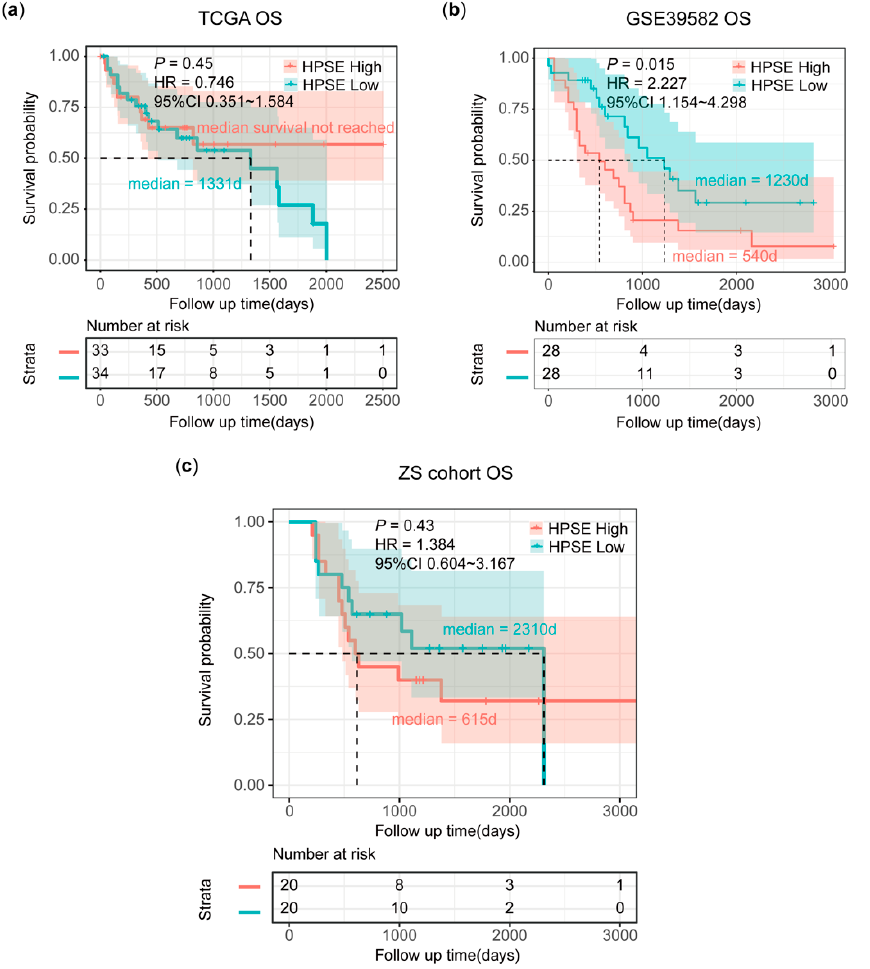
Figure 7. Kaplan–Meier survival curves for pMMR mCRC in TCGA ( a ), GSE39582 ( b ), and ZS ( c ) cohorts. OS, overall survival.